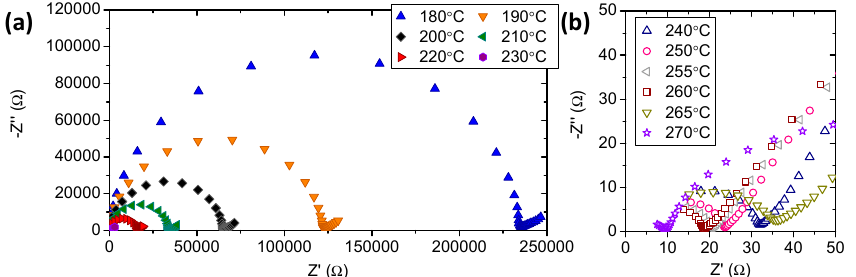
5 of 11 Figure 3. Impedance spectra for CsH 2 PO 4 compound at the studied temperatures: from 180 to 230 °C ( a ) and from 240 to 270 °C ( b ). Conductivity values (S·cm − 1 ) were obtained from the fitting of the electrochemical impedance